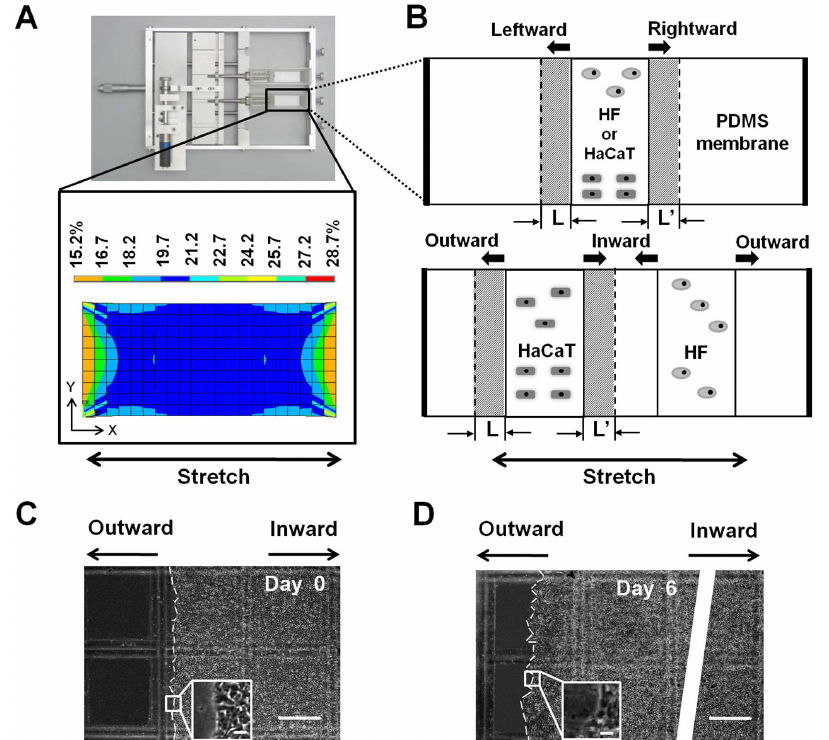
Figure 1. Lateral migration set-up of HaCaT or HF cells cultured on collagen I-coated PDMS membrane in a tensile device. ( A ) An in- house developed tensile device by applying mechanical stretch, via the PDMS membrane, to the cells ( upper panel ). Also plotted was the tensile strain profile of PDMS membrane at a pre-set 20% strain along tensile direction ( x -axis) ( lower panel ). ( B ) Schematic of monocultured ( upper panel ) or cocultured ( lower panel ) HaCaT or HF cells on the stretched membrane where the cells tend to migrate in two directions with a distance L or L’ at a given time point. Arrows indicate the migration direction of the cells when they are monocultured (to leftward or rightward) or cocultured (to outward or inward). ( C , D ) Typical images of cocultured HaCaT cells at t =0 ( C ) and 6 day ( D ) with the leading edge indicated as white dashed lines ( Bar =500 m m) with the inserts illustrating the magnified images ( Bar =100 m m). The white strip in ( D ) was used to disconnect the oversized image.